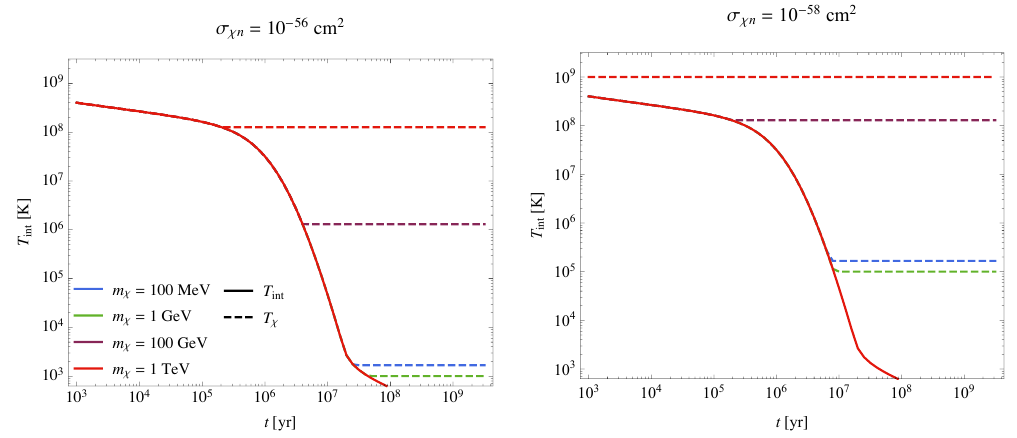
Figure 1 . The evolution of T int (solid) and T (cid:31) (dashed). DM masses m (cid:31) are marked with di(cid:11)erent colors. When T (cid:31) is cold enough at some time, the corresponding t th is longer than t NS . Therefore, T (cid:31) will decouple from T int since then ((cid:13)at dashed lines). We use (cid:27) (cid:31)(cid:31) =m (cid:31) = 4 cm 2 g (cid:0) 1 and h (cid:27)v i = 3 (cid:2) 10 (cid:0) 26 cm 3 s (cid:0) 1 in the calculation. See main text for detail.